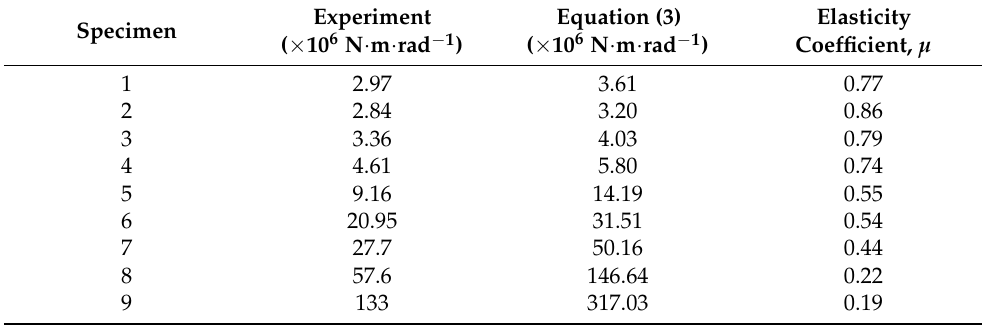
Table 2. Elasticity coefficient, µ .